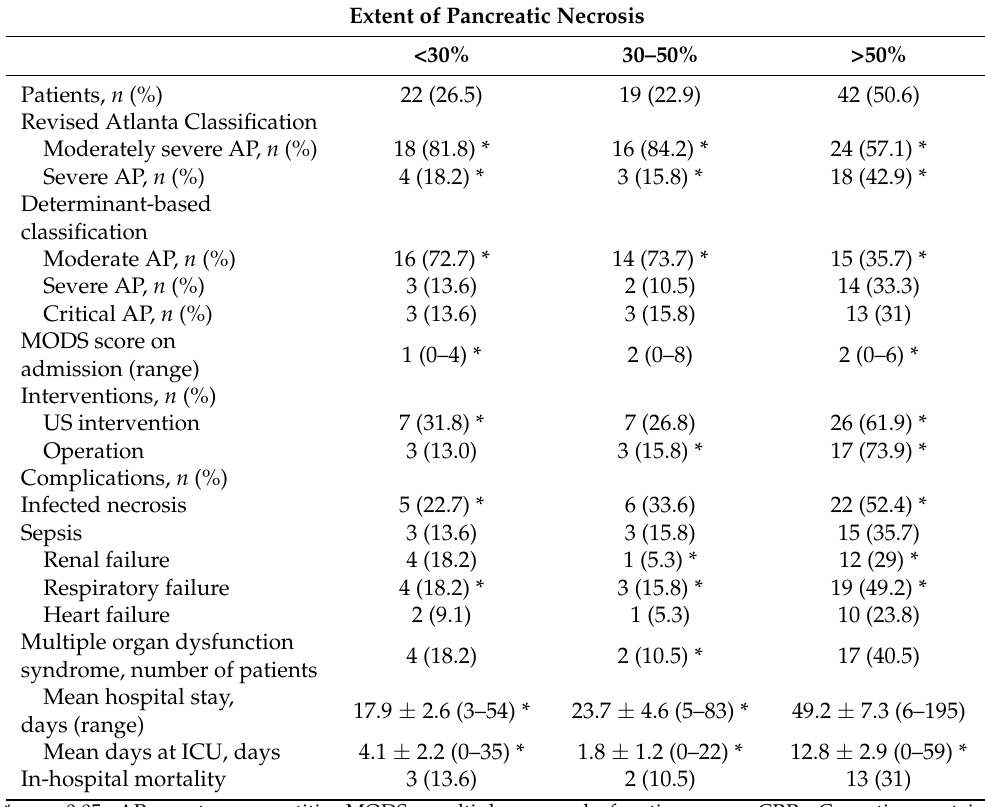
Table 3. Clinical outcome by the extent of pancreatic necrosis.